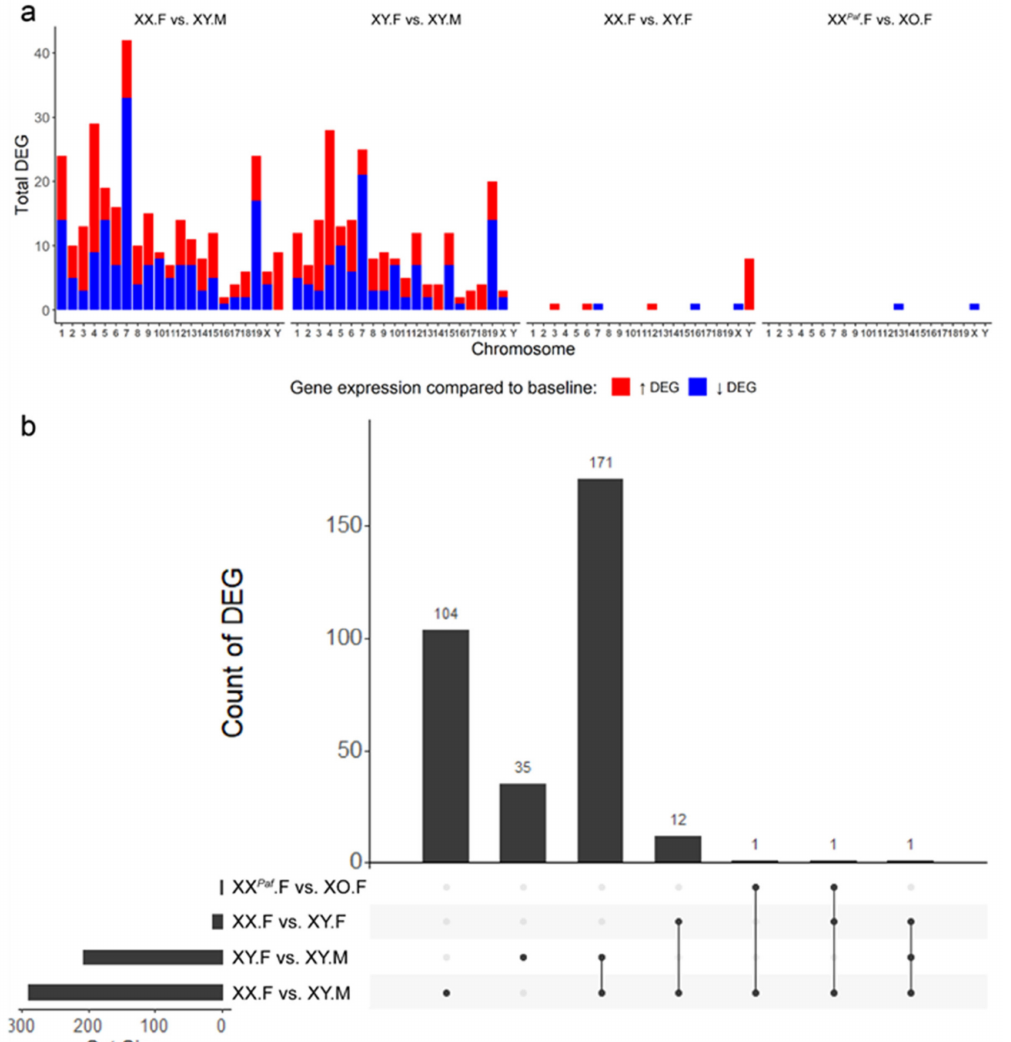
Figure 5. Distribution of di ff erentially expressed genes (DEGs) across chromosomes and overlap of DEG across comparisons. ( a ) Counts of DEG per chromosome in each of the four comparisons. The x -axis represents chromosome ID, and the y -axis represents the number of DEG on each chromosome. Red portions of the bars correspond to DEG that had higher expression (absolute log 2 fold change > 1.5; adjusted p -value < 0.05) in the sample compared with baseline, where baseline samples were XX.F (XX.F vs. XY.M), XY.F (XY.F vs. XY.M), XX.F (XX.F vs. XY.F), and XX Paf .F (XX Paf .F vs. XO.F). The blue portion represents DEGs that had lower expression in the sample compared with the baseline. ( b ) UpSet Plot shows overlap of DEG detected across comparisons. Each horizontal bar on the left represents the total number of DEGs identified in each comparison. Each vertical bar shows the size of a subset identified in one or multiple